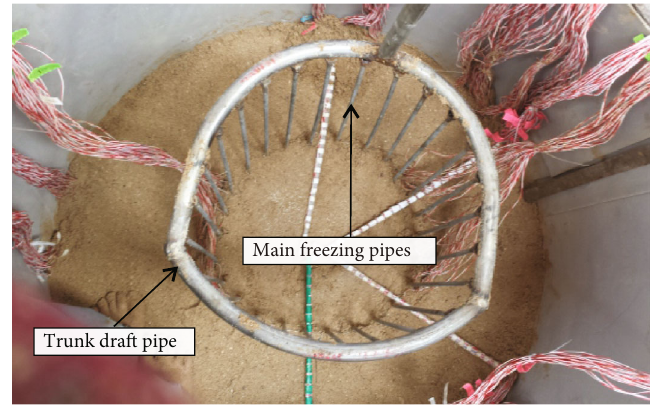
Figure 4: Layout of freezing pipes.